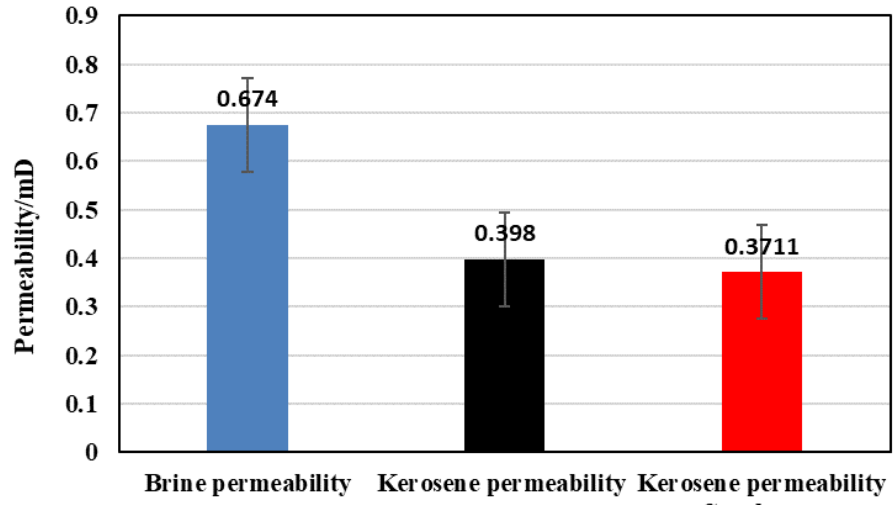
Figure 16. Core entrance observed by microscope.